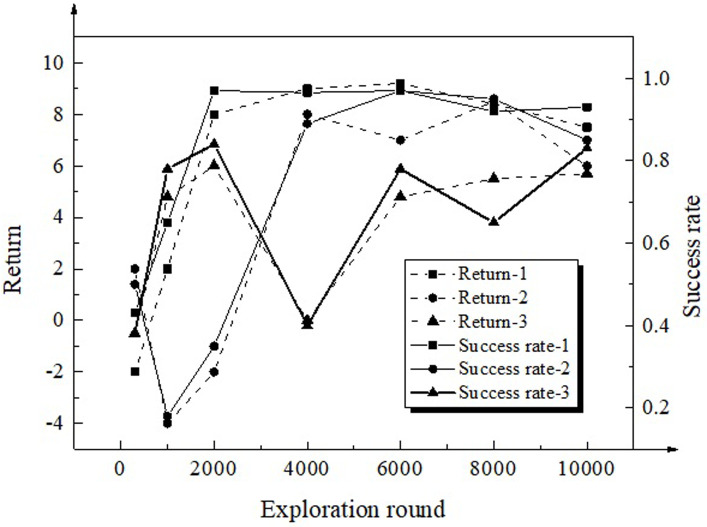
Performance test results of meta value network in H-DDPG algorithm under three scenarios.